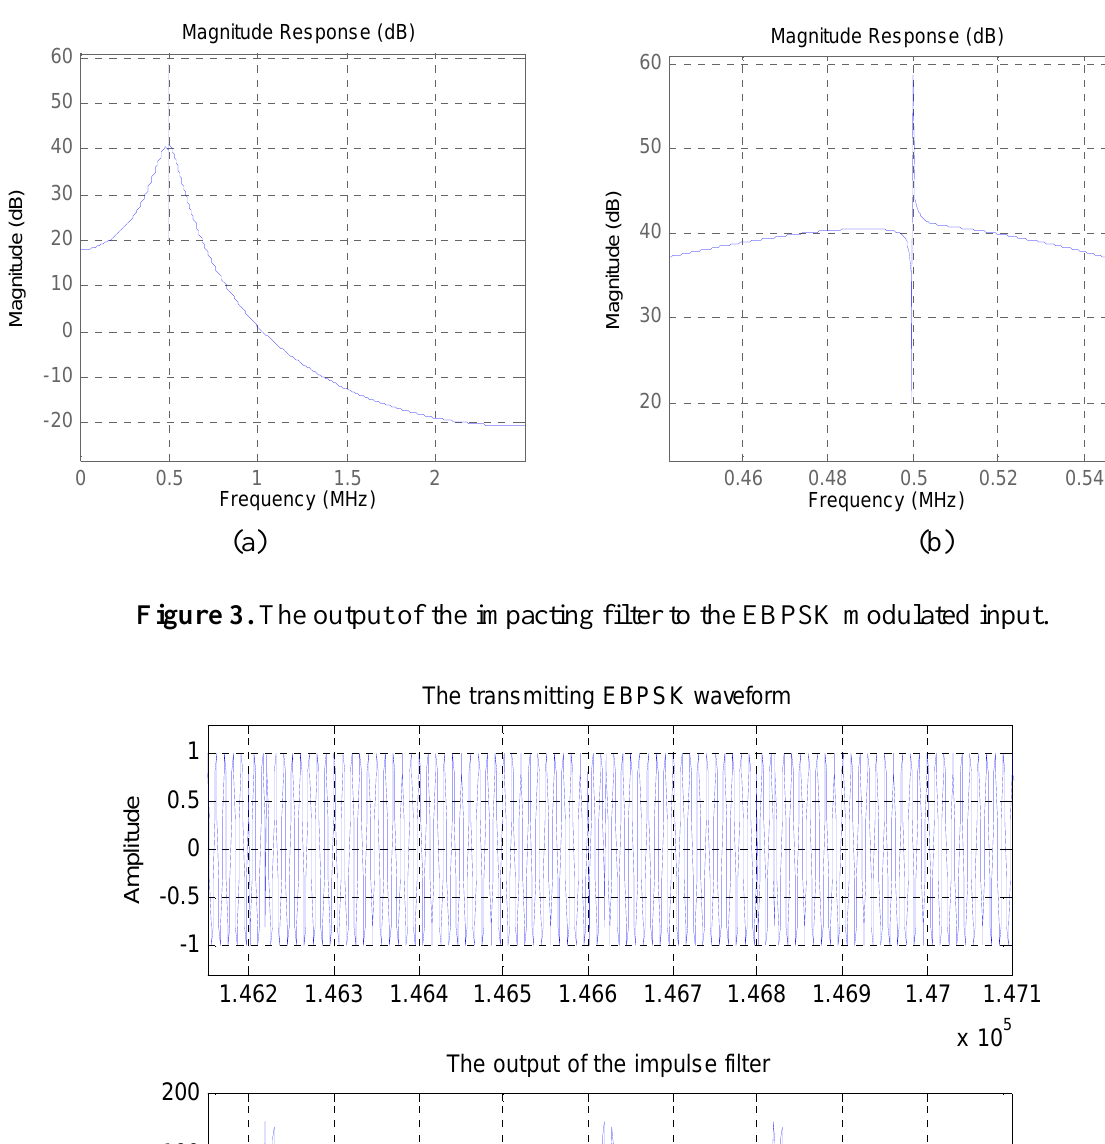
Figure 2. (a) The amplitude-frequency response of an “impacting filter”. (b) The zoomed figure of (a).